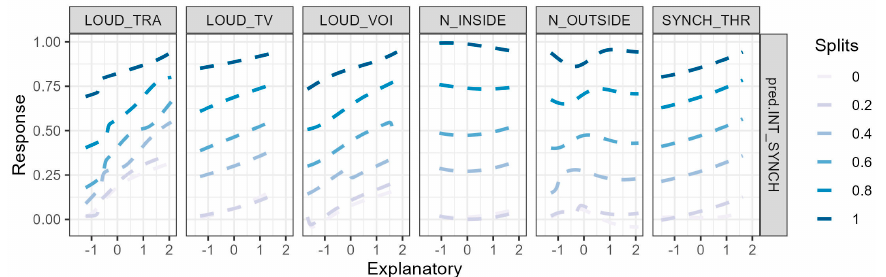
Figure 12. Artificial neural network representation of the model for the noise interference with synchronous activities. The black lines represent positive weights and the grey ones negative. Line thickness is the relative weight with respect to the other variables.